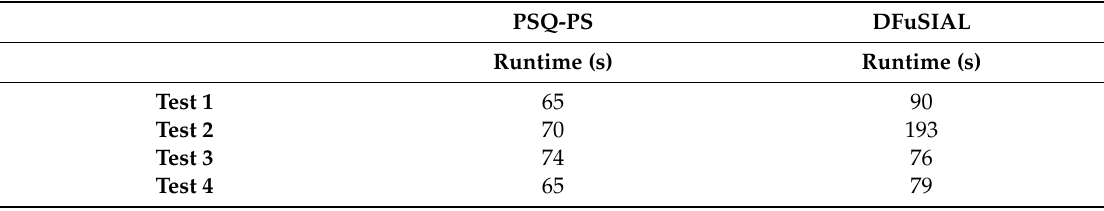
Table 6. Run time (sec) for PSQ-PS and the proposed fusion method DFuSIAL in Tests 1-4.